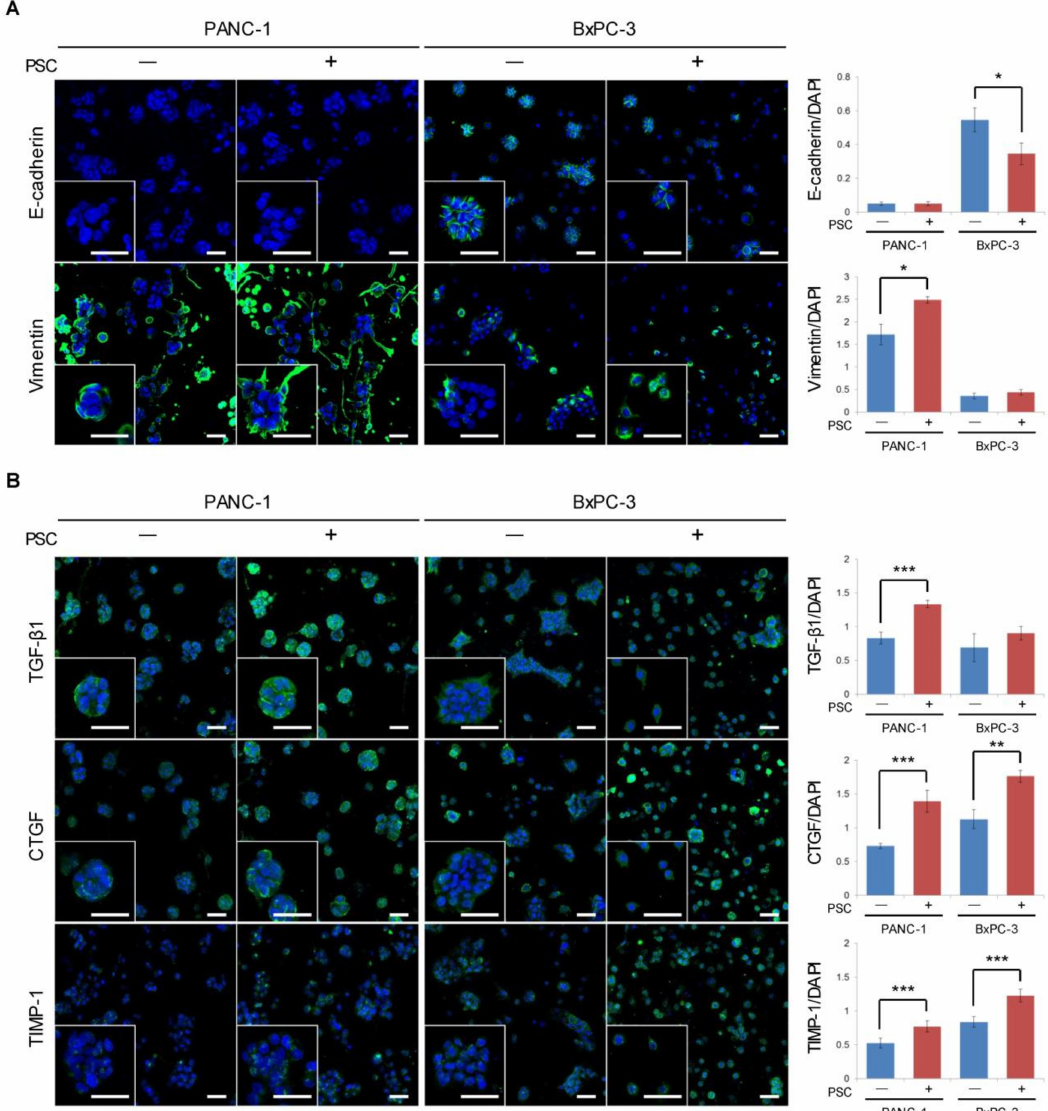
Figure 2. Expression of epithelial-mesenchymal transition (EMT)-related proteins in tumor spheroids (TSs) under PSC co-culture conditions. ( A ) Expression of EMT marker proteins E-cadherin and vimentin. ( B ) Expression of EMT-inducing factors TGF- β 1, CTGF, and TIMP-1. Protein expression levels were normalized by nuclear staining with DAPI. Optical sections were acquired at 6 µ m (10 × ) or 2 µ m (40 × ) intervals and stacked into a z-projection. Cells were grown for 5 days in collagen-supported microchannel chips. Three fields covering 80% of the e ff ective area in each channel were imaged per experiment and subjected to analysis. Data were obtained from three separate independent